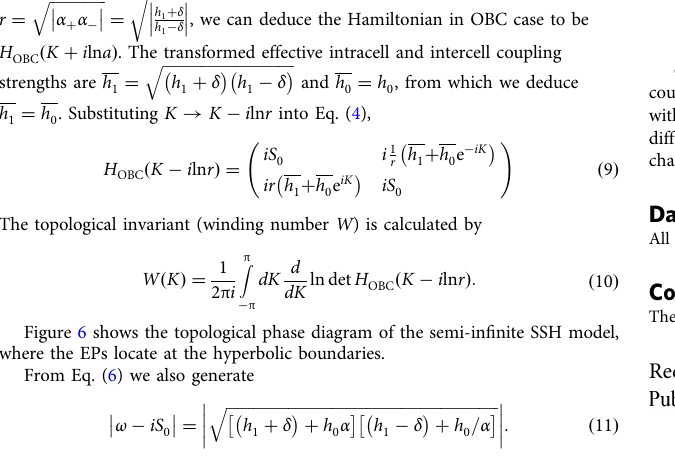
Methods EPs in the topological phase . As the transformation factor (cid:9)r ffiffiffiffiffiffiffiffiffiffiffi (cid:9) (cid:9) ffiffiffiffiffiffiffiffiffiffiffiffiffiffiffi (cid:9) (cid:9) (cid:9)q (cid:9) (cid:9) (cid:9) h 1 þ δ α ¼ α (cid:9) , we can deduce the Hamiltonian in OBC case to be r ¼ þ (cid:2) h 1 (cid:2) δ H OBC K þ i ln a ð Þ . The transformed effective intracell and intercell coupling strengths are h 1 ¼